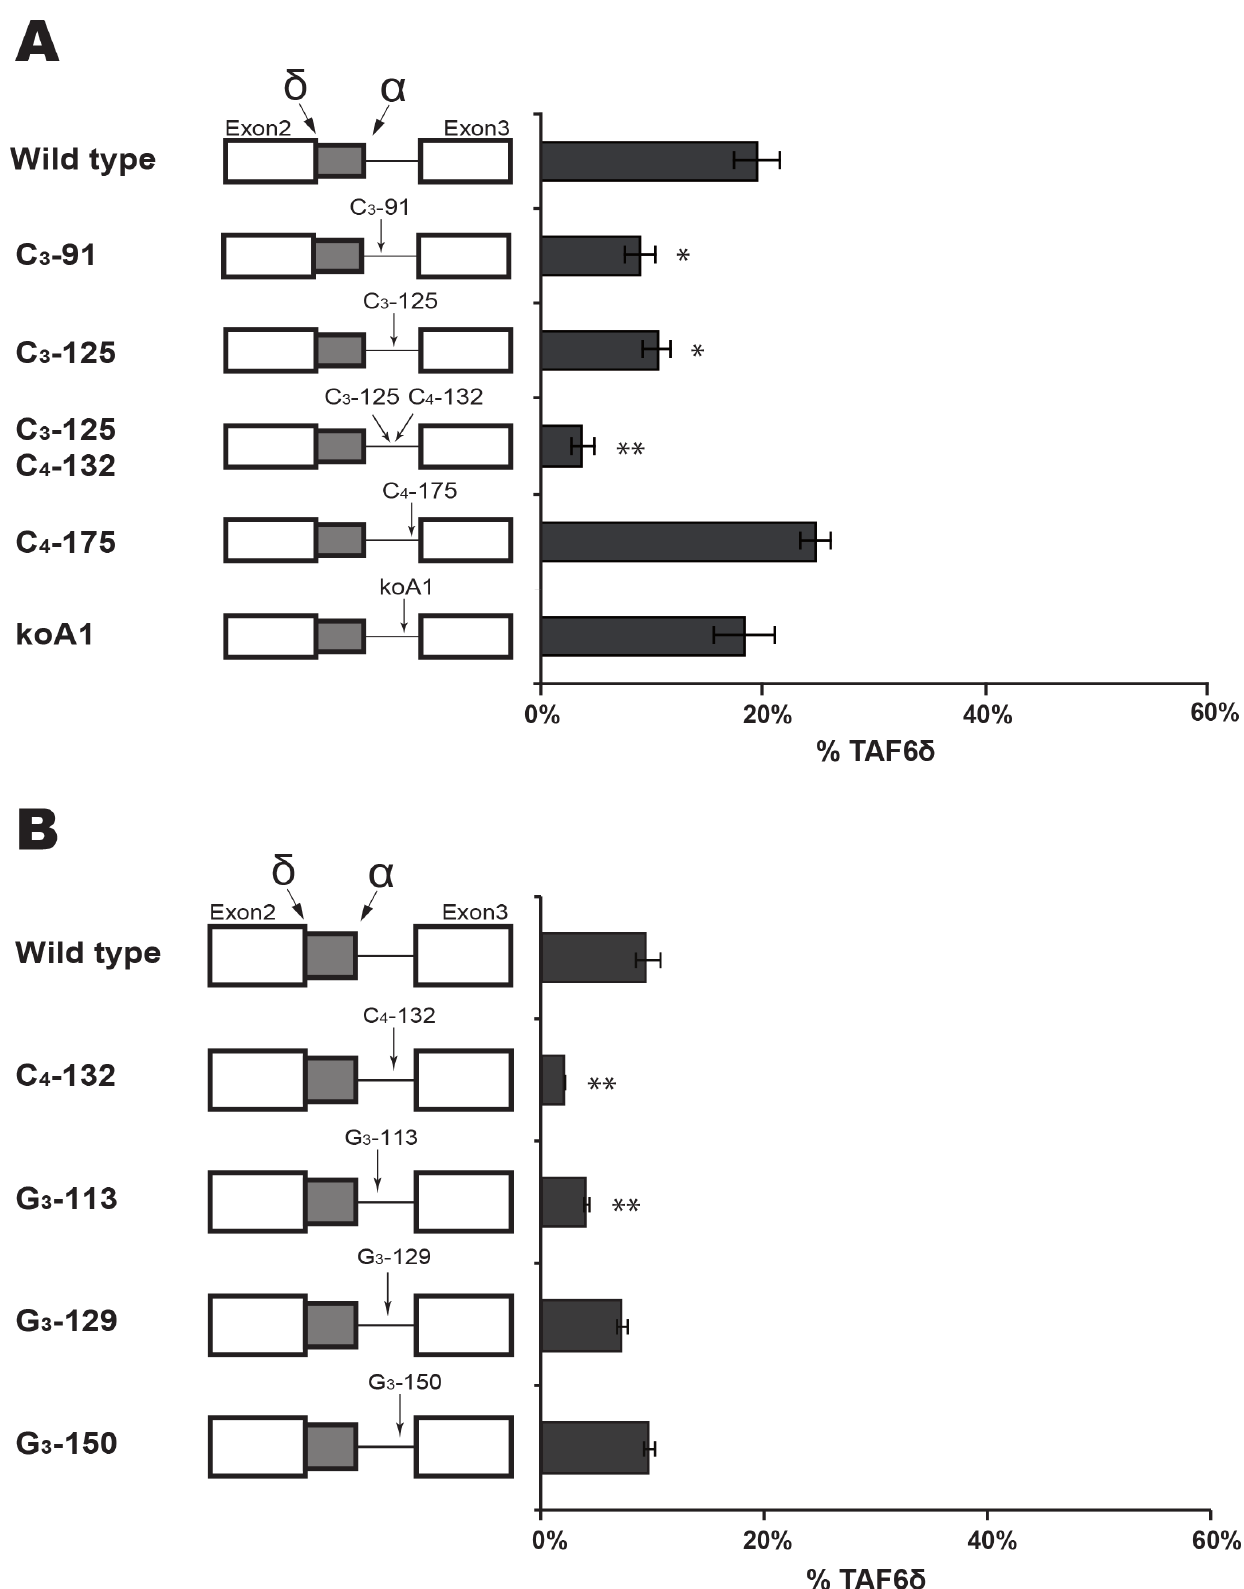
Figure 5. Targeted mutagenesis of intron 2 of the taf6 gene. (A) Mutations of intron motifs are indicated with arrows in the TAF6 minigene constructs. HeLa cell transfection and splice product analysis was carried out as in Figure 3. The percentage of exogenous TAF6 d mRNA is graphically shown (x-axis). (B) As in panel A except mutations were focused on poly G motifs found within intron 2. (P , 0.05=*; P , 0.01=**; P , 0.001=***). doi:10.1371/journal.pone.0102399.g005 PLOS ONE |